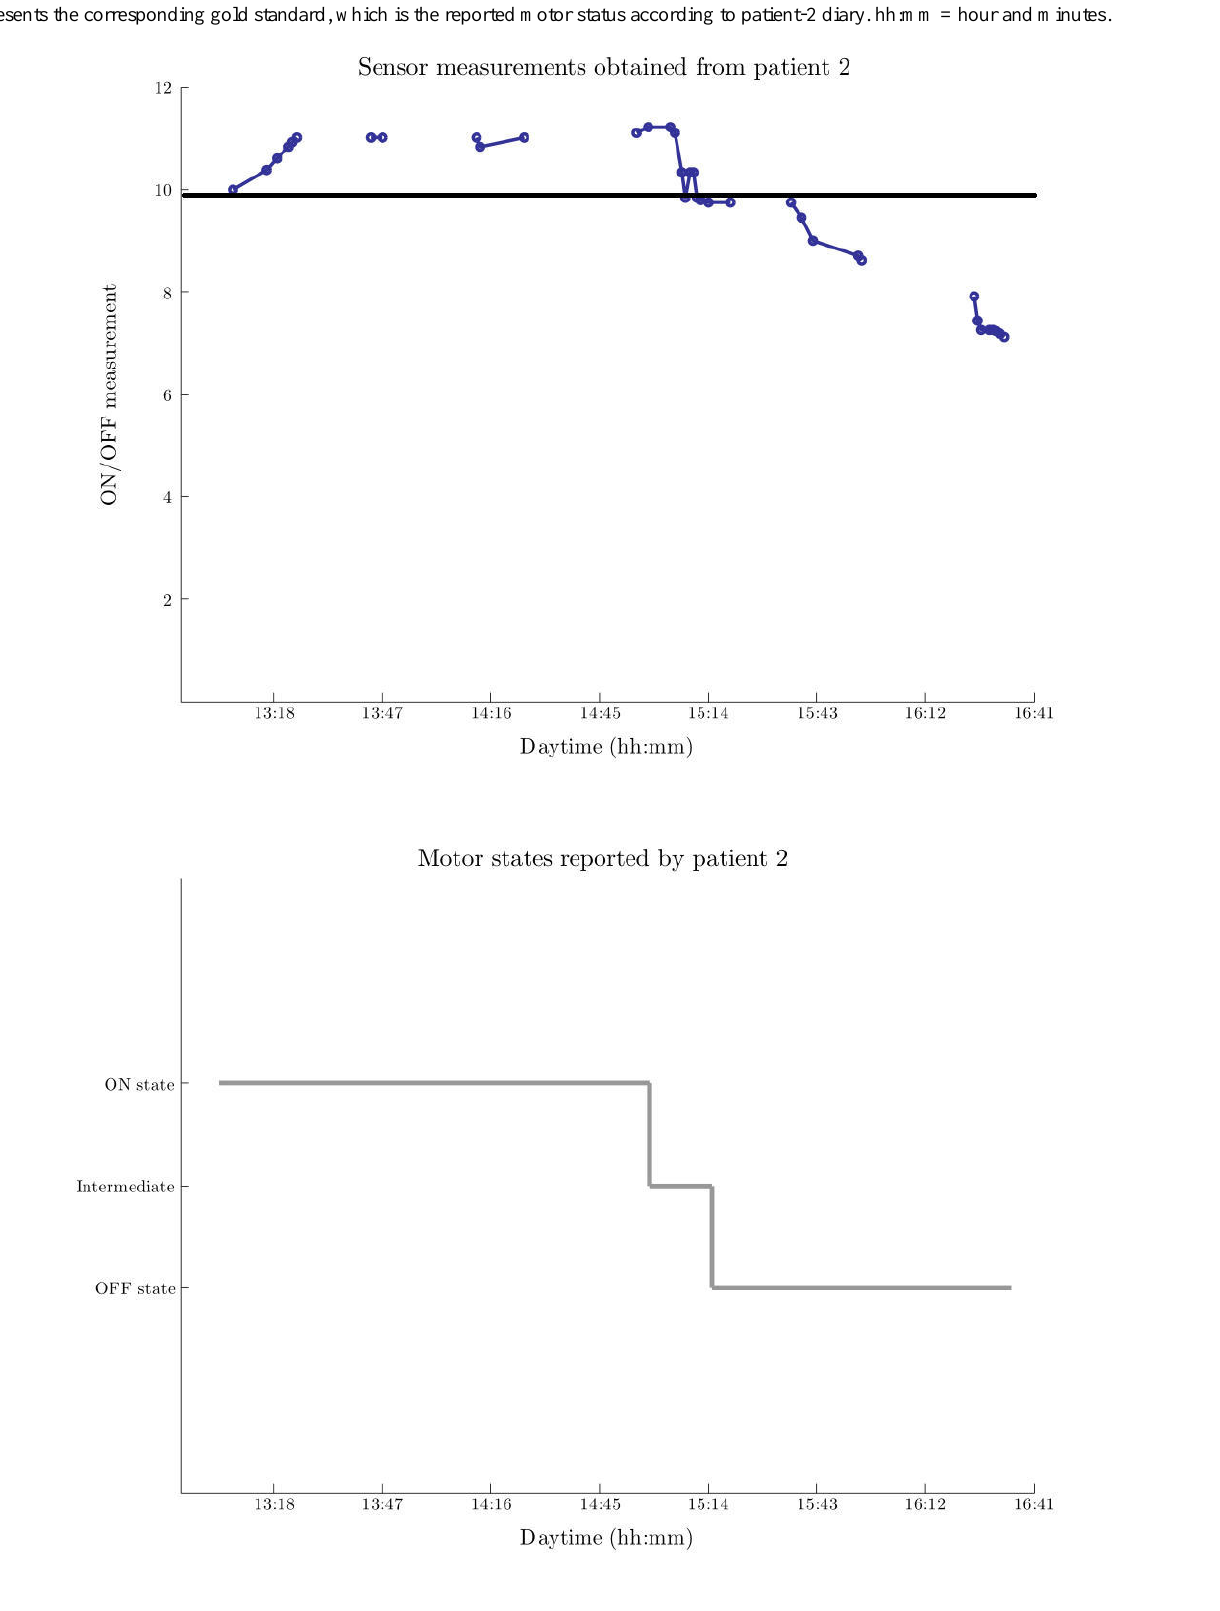
Figure 2. Upper figure shows sensor’s measurements along time for patient 2. Threshold found to separate motor states is also depicted. Lower figure presents the corresponding gold standard, which is the reported motor status according to patient-2 diary. hh:mm = hour and